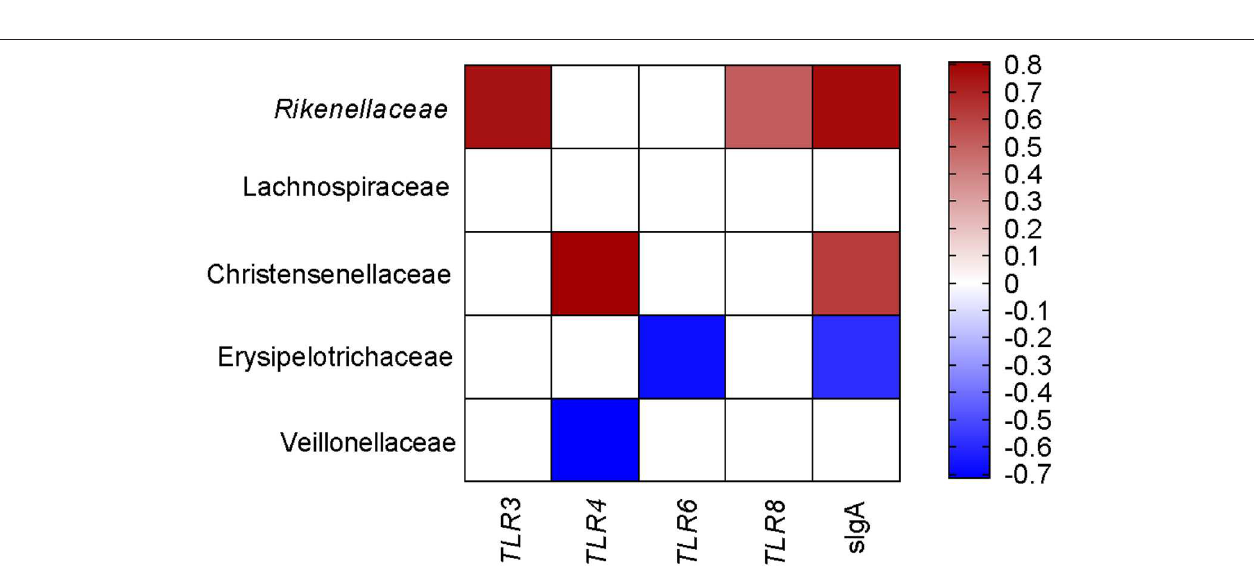
FIGURE 4 | Effect of FF on the content of sIgA in the colonic mucosa. Ctrl, pigs fed with normal commercial feed; FF, pigs fed with fermented meal. Data are presented as mean ± SEM ( n = 6). * P < 0.05. (A) Duodenal mucosa; (B) Colonic mucosa.